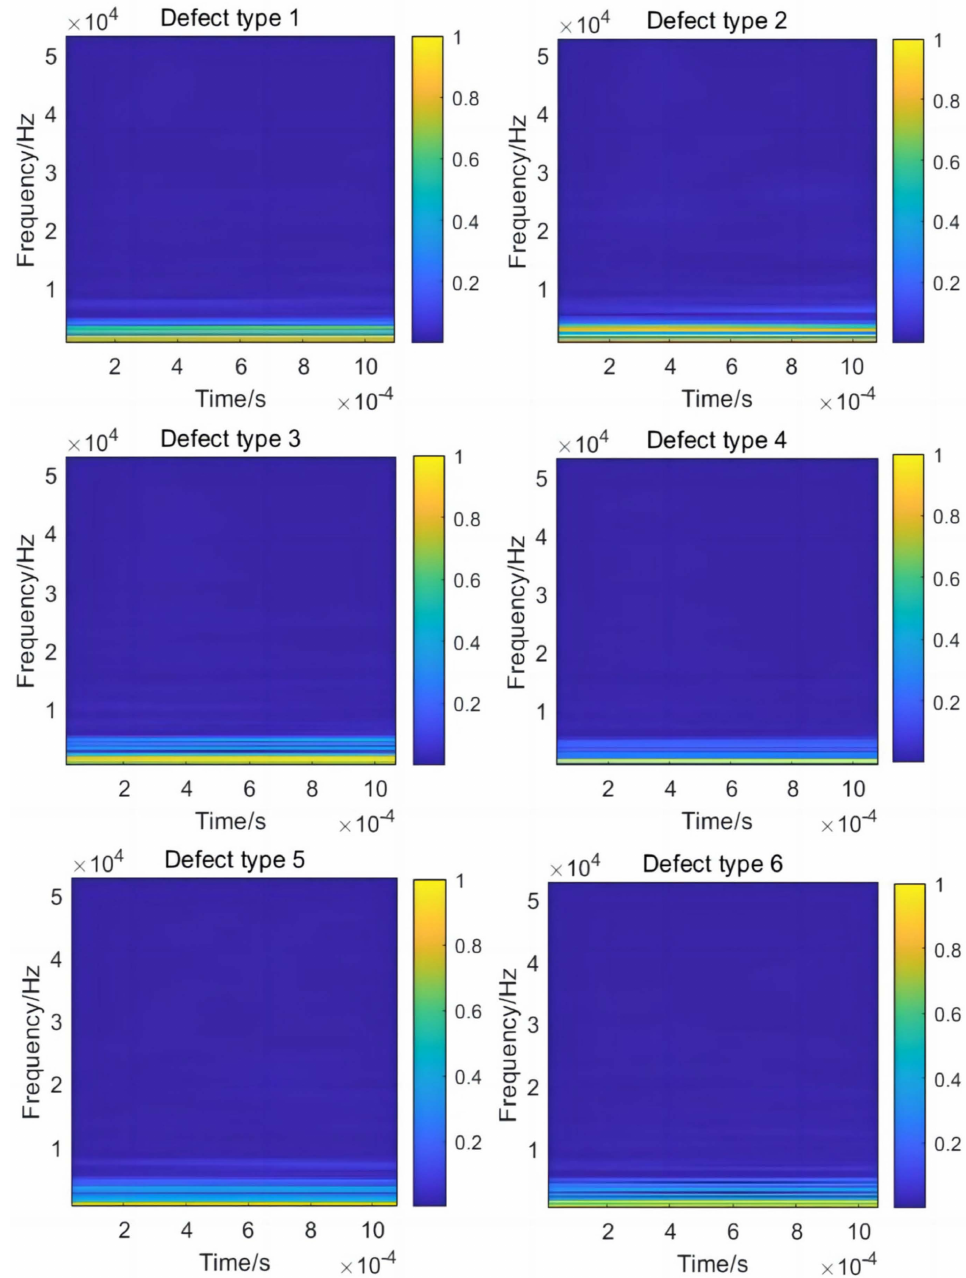
Figure 9. Wavelet time–frequency diagram of 6 kinds of multi-defect